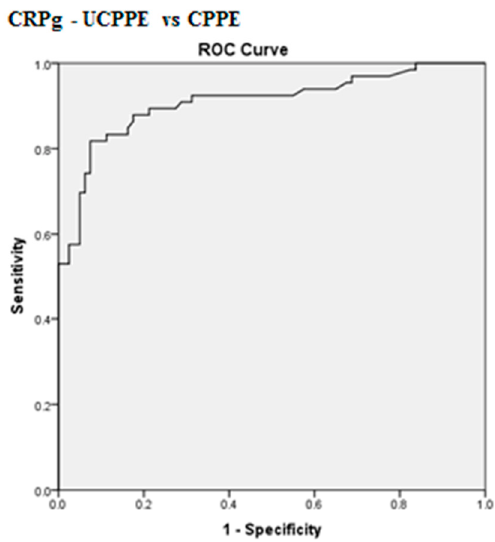
Figure 6. ROC curve of best cut-off value of CRPg for discrimination between UCPPE and CPPE. CRPg best cut-off value = 142 mg/L, AUC = 91% (95% CI: 85.8–96.0), sensitivity = 90%, specificity = 86%, total accuracy = 88%, PPV = 82%, NPV = 92.5%, odds ratio = 55.5 (risk for CPPE when CRPg value > 142 mg/L), p < 0.0001.